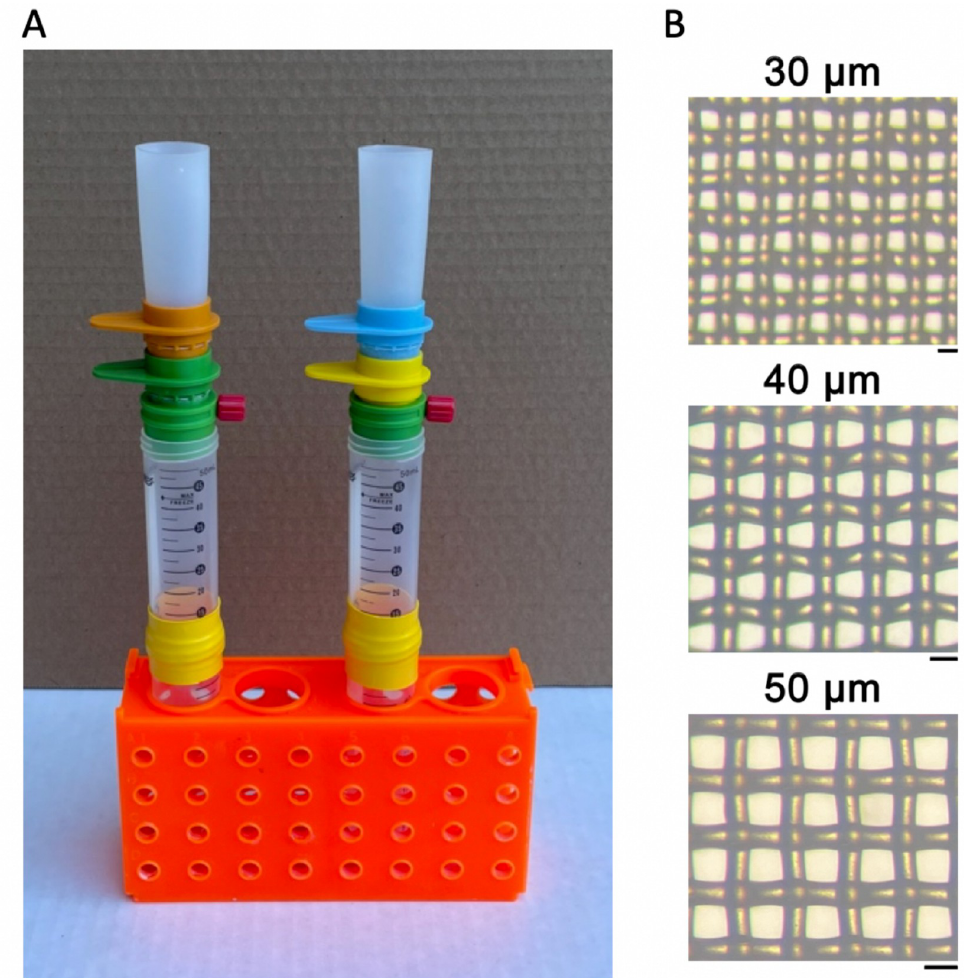
Fig 1. Filtration apparatus. A. Left, strainer stack for pre-filtration. An 85 μ m strainer (orange) is stacked on a 20 μ m strainer (green). A funnel is inserted into the 85 μ m strainer and the 20 μ m strainer is inserted into an adapter whose vent port is closed by a red cap. Right, strainer stack for 1-step passage, 40 μ m filtration. A 40 μ m strainer (blue) is stacked on a 5 μ m strainer (yellow). B. Micrographs of the mesh in 30, 40, and 50 μ m strainers. Scale-bars equal mesh size.